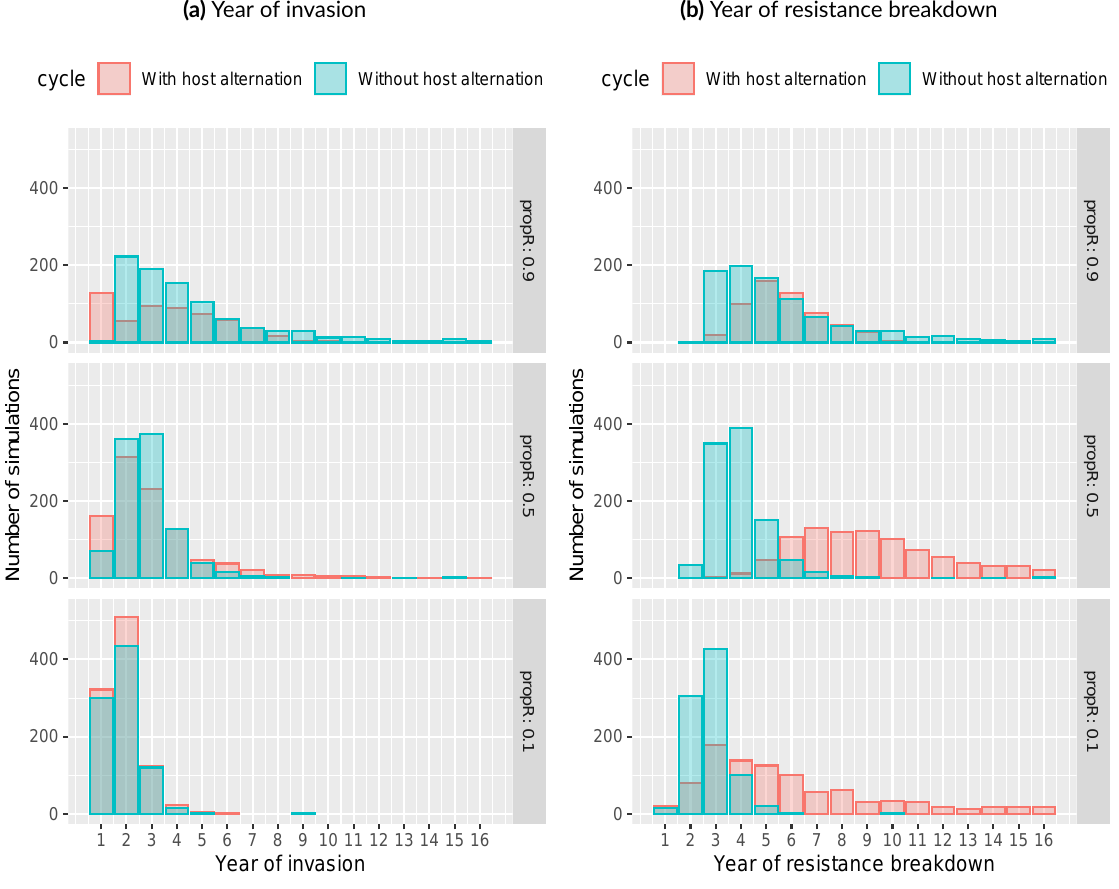
Figure 6 – Histograms of (a) the year of invasion and (b) the year of resistance breakdown depending on the life cycle of the diploid pathogen, for three values of propR . Simulations were performed with f avr = 0.02 , mig = 0.05 , and r = 1.5 . The plotted results were obtained from the restricted simulation design, and correspond to all simulations among the 1 000 replicates per combinations for which we observed a fixation of the avr allele in the